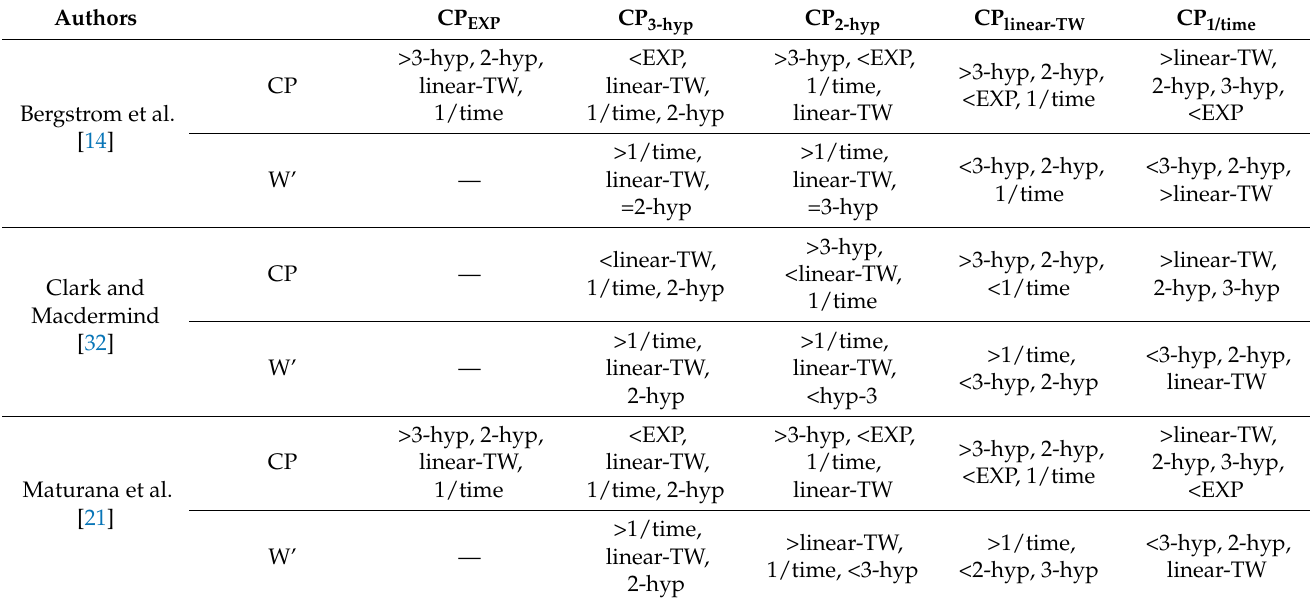
Table 2. Comparison of CP and W’ from different mathematical models using TTE and TT